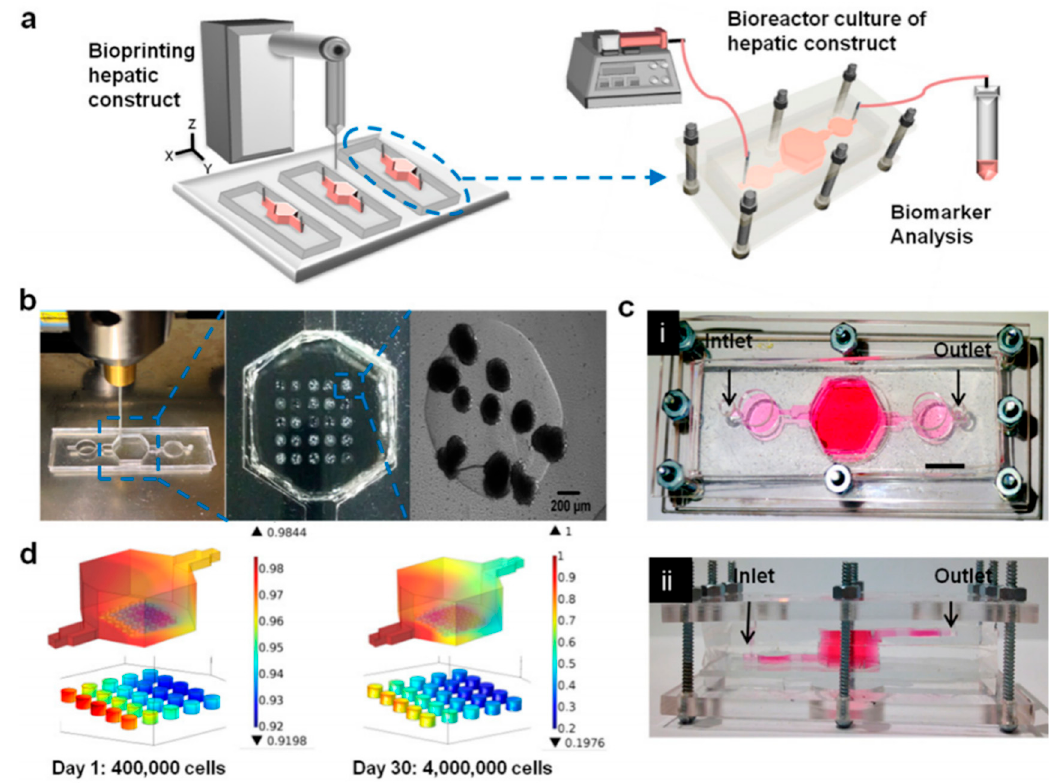
Figure 10. ( a ) Schematic of the hepatic bioreactor culture platform integrated with a bioprinter and biomarker analysis module. ( b ) Bioprinting photocrosslinkable Gelatin-methacryloyl (GelMA) hydrogel-based hepatic construct within the bioreactor as a dot array. ( c ) Top-view (i) and side-view